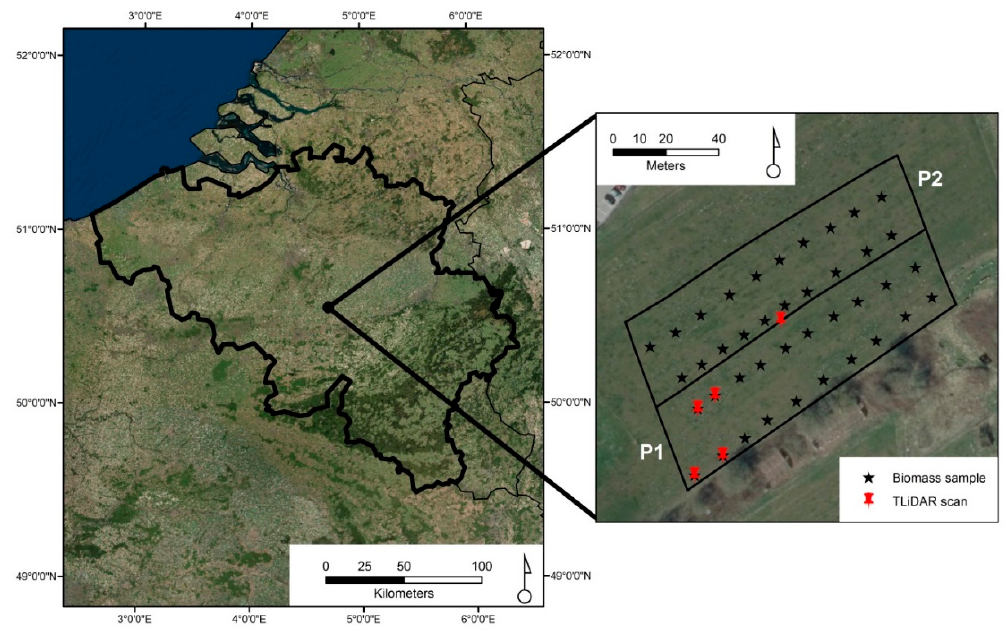
Figure 1. Study site location in Belgium (Western Europe) and locations of the field measurements (biomass sampling and terrestrial LiDAR scans)). P1 and P2 were grazed for two consecutive days. Eight ground control points (GCPs) consisting of 0.4 m white square plastic plates were placed in ( ± 0.04 m mean XYZ